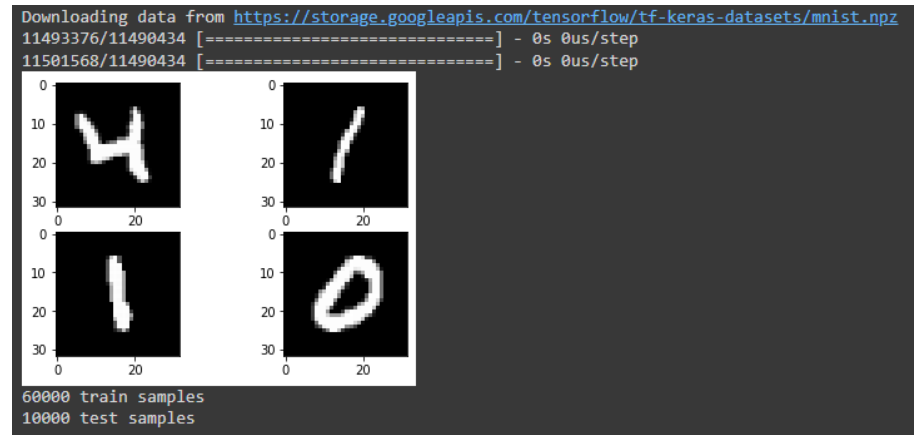
Figure 4. Dataset download and printing of random samples.